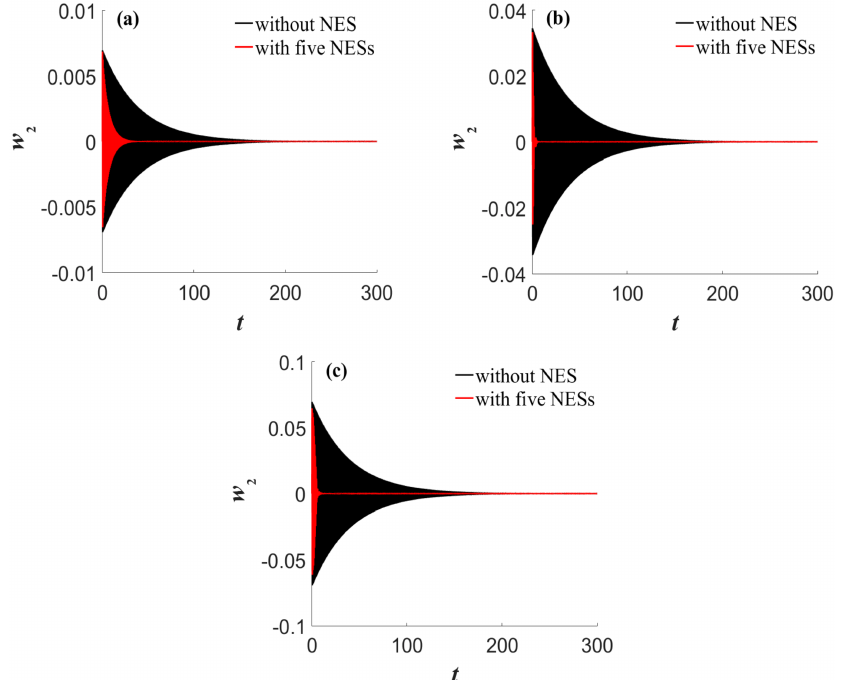
Figure 9. The second-order transient response of sandwich plate under different excitation ampli- tudes: ( a ) f = 1; ( b ) f = 5; and ( c ) f =